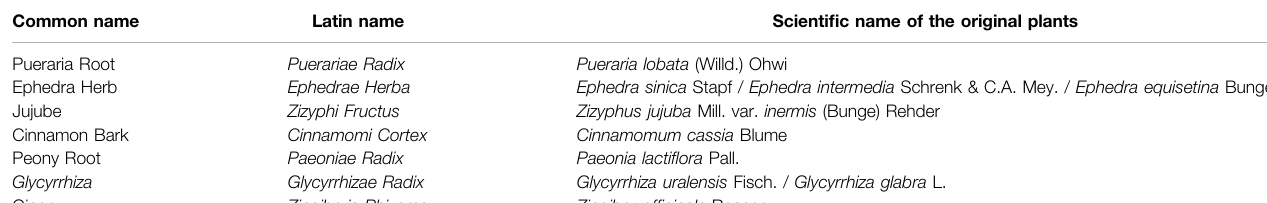
TABLE 2 | Original plants of kakkonto extract used in the study.